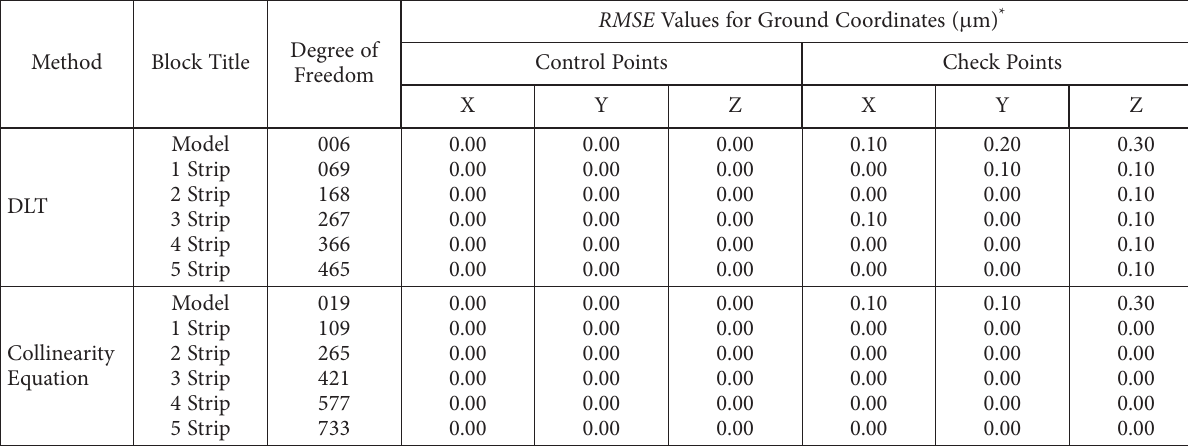
Table 4. Results of self calibration block adjustment (Case of lens distortions errors